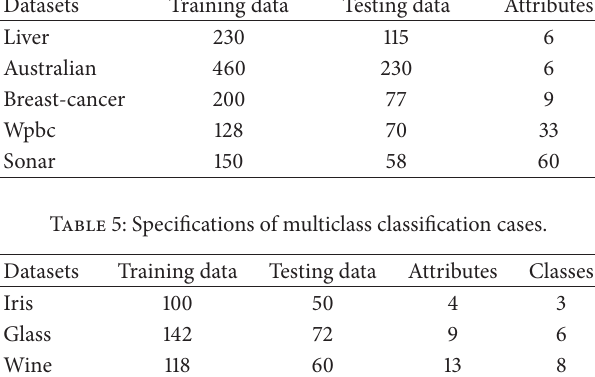
Figure 7: The boundaries of Poly KELM algorithms in Banana